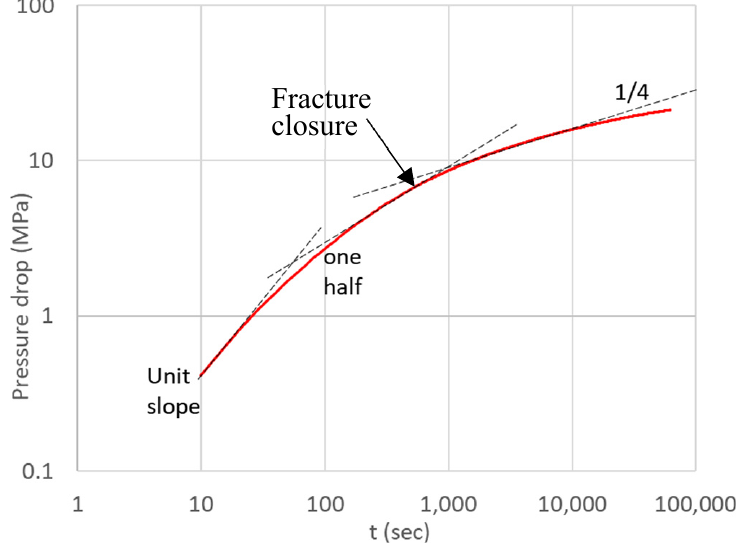
Figure 14. Diagnostic plot for Zone 2 Cycle 8. The fracture closure is picked at the end of the half-slope. Hence, the surface pressure at closure is 21.1 MPa (instantaneous shut-in pressure (ISIP) 27.0 MPa minus the pressure drop of 5.9 MPa). The calculated bottomhole pressure at closure is 41.9 MPa, and the closure stress gradient is 19.7 MPa/km.